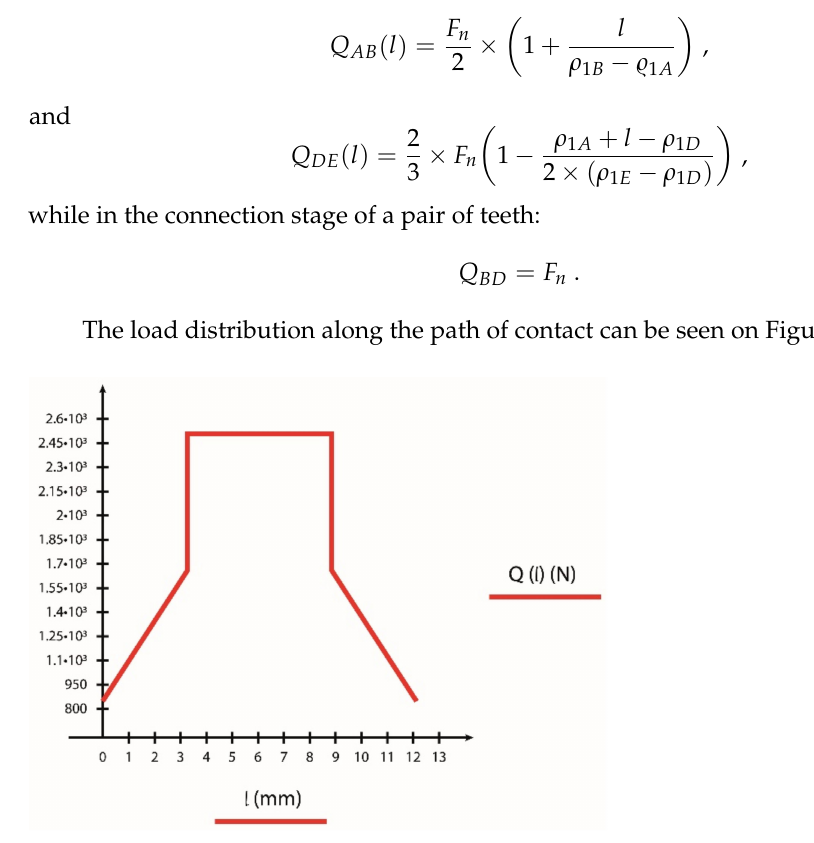
Figure 2. Based on the presented load model, the load change along the path of